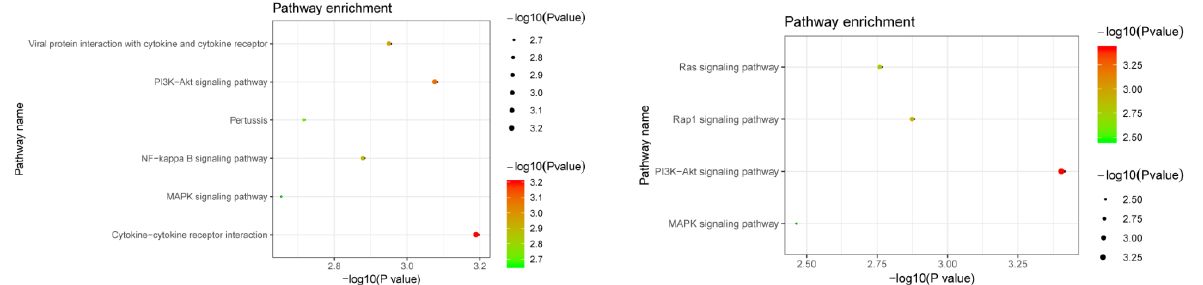
Figure 5. Pathway enrichment of the identified proteins. The upper panel shows the pathways for proteins affected by RNAm-SNPs identified in pQTL analysis; the lower panel shows the pathways for potential causal proteins identified in MR analysis.